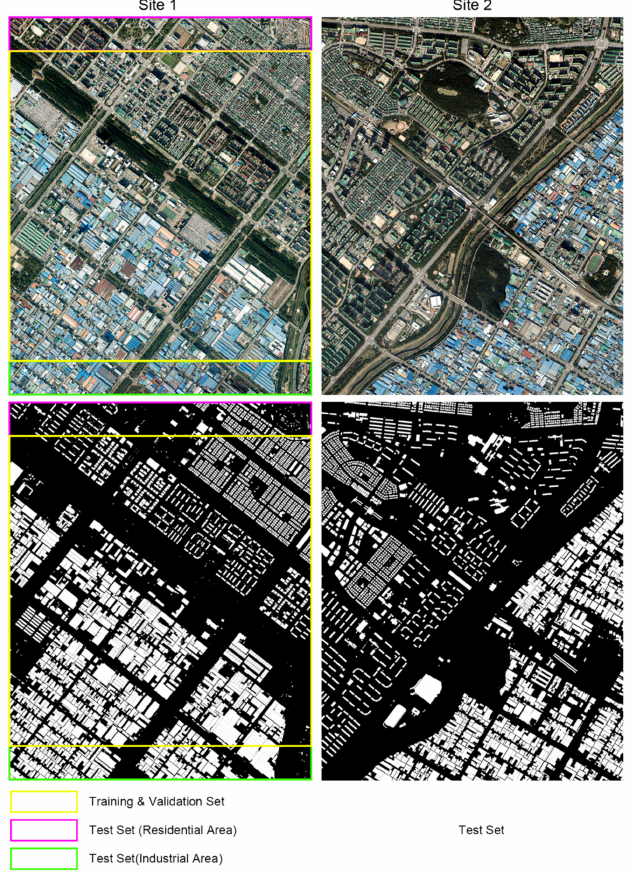
Figure 6. Aerial images from Ansan and Siheung, South